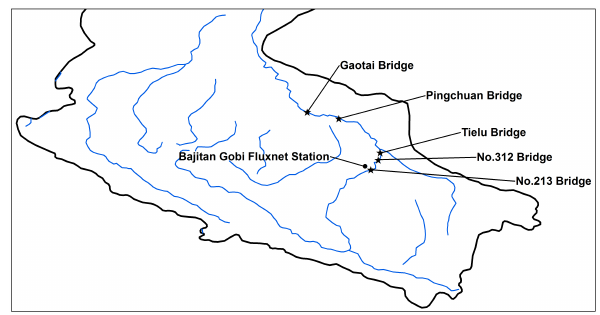
Figure 3. Locations of the five sections in the middle reaches of the Heihe River that were used for simulations and the location of Bajitan Gobi FLUXNET station that was used for